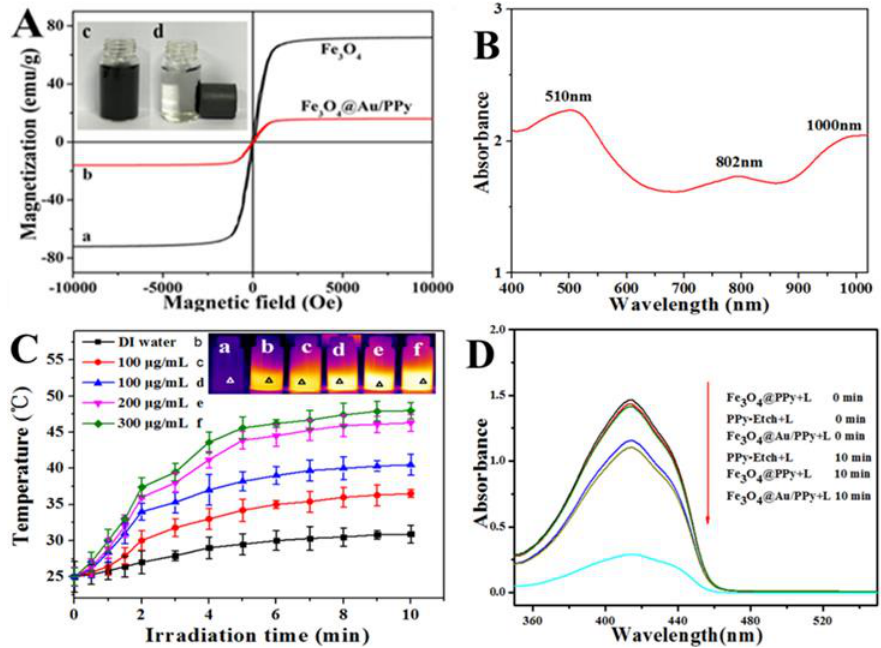
Figure 2. ( A ) Magnetization curves of (a) Fe 3 O 4 and (b) Fe 3 O 4 @Au/PPy nanocomposites. The top left inset presents photographs of the Fe 3 O 4 @Au/PPy aqueous dispersion (c) before and (d) after magnetic separation by an external magnetic field. ( B ) UV ‐ Vis ‐ NIR spectrum of Fe 3 O 4 @Au/PPy. ( C ) Temperature change curves and thermal images (inset) of (b) the DI water; (c) Fe 3 O 4 @PPy at 100 μg/mL ; Fe 3 O 4 @Au/PPy at (d) 100 μg/mL, (e) 200 μg/mL and (f) 300 μg/mL irradiated with 808 nm laser at 1 W/cm 2 for 10 min. In the inset, (a) shows the thermal image of the DI water at room temperature (25 °C). Error bars are based on at least triplicate measurements. ( D ) Absorbance changes at 410 nm of DPBF solutions in the presence of Fe 3 O 4 @PPy, PPy ‐ Etch and Fe 3 O 4 @Au/PPy with or without irradiation (808 nm). L represents light irradiation.